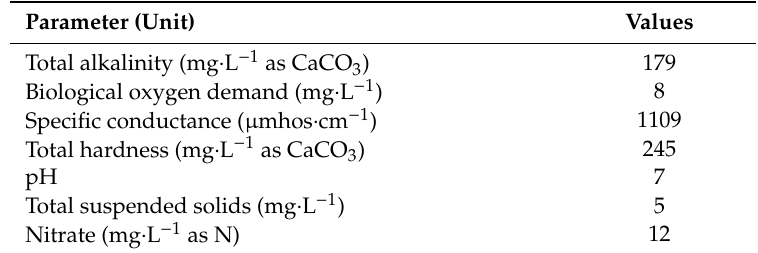
Table 1. Average chemical characteristics of the municipal wastewater used for irrigation from November 2005 until August 2006 ( n = 21) [44].